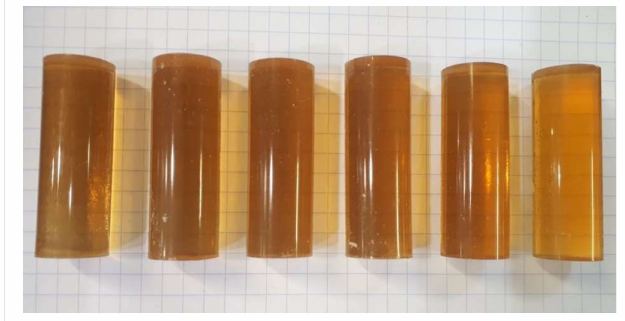
Figure 2. Cylindrical samples of epoxy.